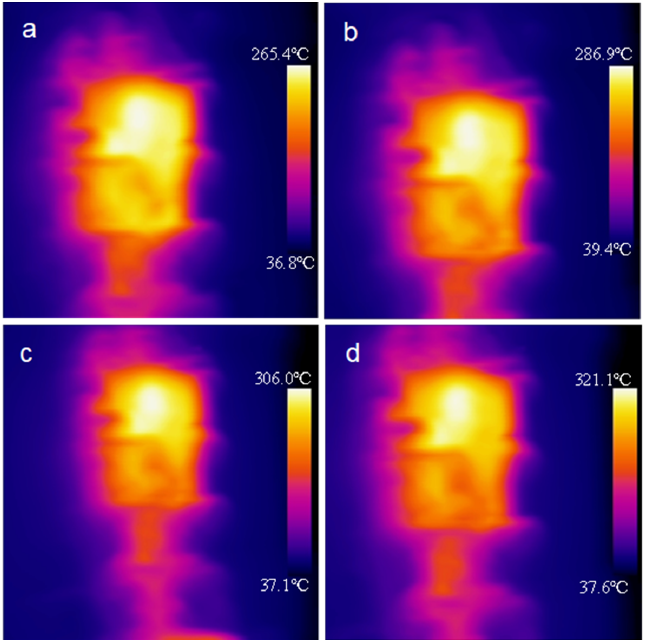
Figure 8. Thermography images of ejector die after the castings being ejected under conditions of different melt injection temperature: ( a ) melt injection temperature was 620 °C, ( b ) melt injection temperature was 640 °C, ( c ) melt injection temperature was 660 °C and ( d ) melt injection temperature was 680 °C.